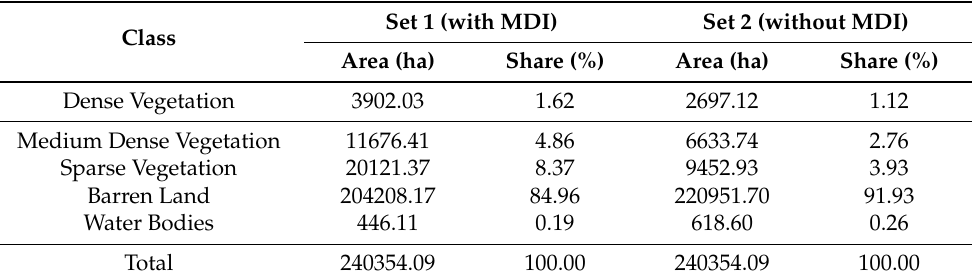
Table 2. Estimates of landcover classes (ha) considered in the analysis in the study area. Set 1 uses a set of variables that include texture features and MDI, and Set 2 uses a set of variables that include texture features but without